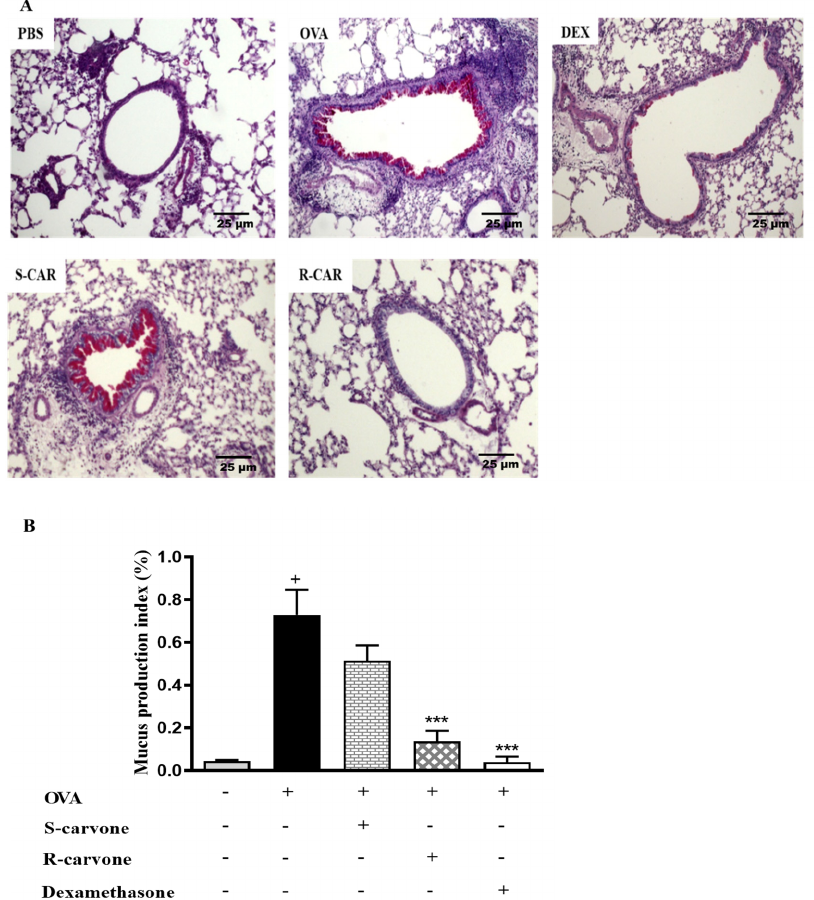
(Table 2) of mucus production, corroborating the pharmacological phenomenon demonstrated in the representative photomicrographs.